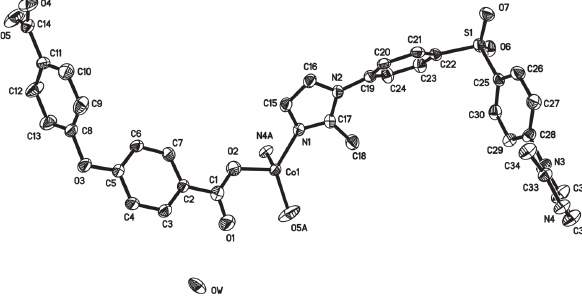
Table 1: Data collection and handling.